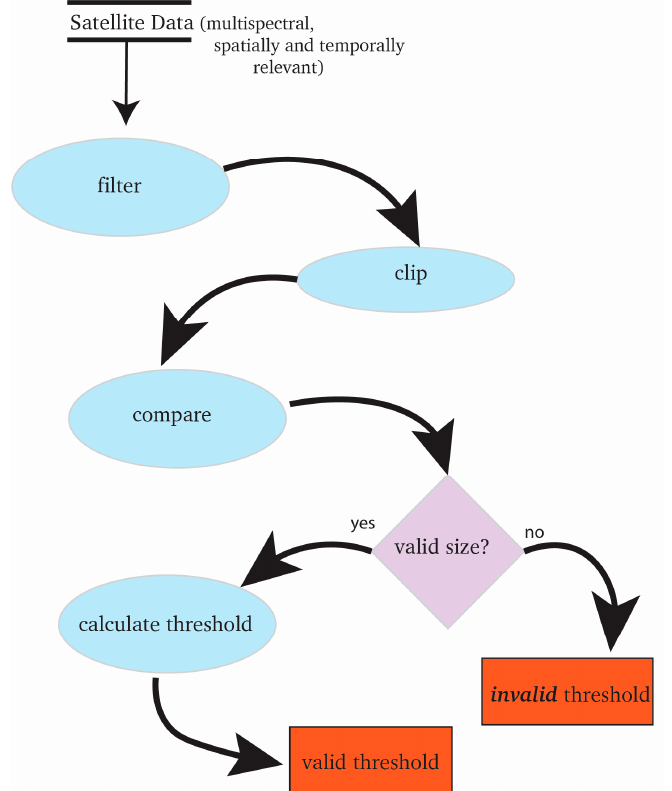
Figure 2. BRIGHT thresholds differ in terms of being taken either over multiple days, or the single (current) day. BRIGHT thresholds (for reflectance, TIR, and MIR) are calculated in a specific order with the results of the preceding threshold variables used to calculate subsequent ones.